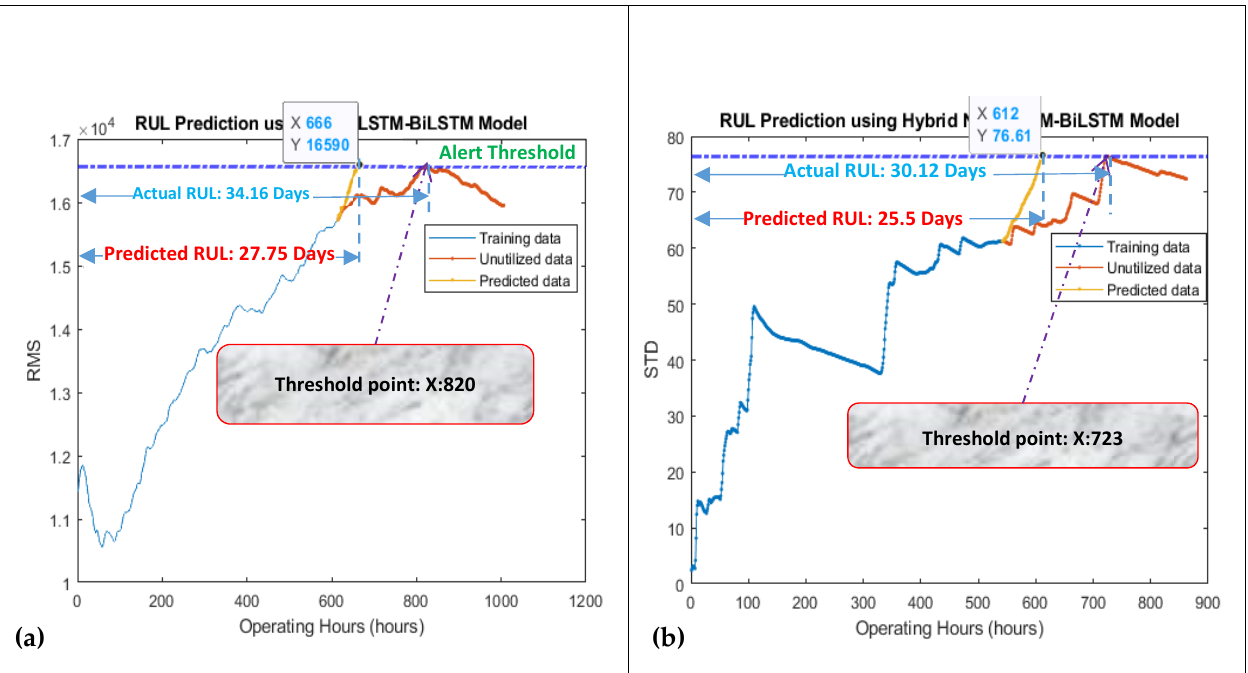
Figure 10. Prediction of overall RUL using 75% data of degradation trends for ( a ) dataset 2014, and ( b ) dataset 2017, for channel 4.